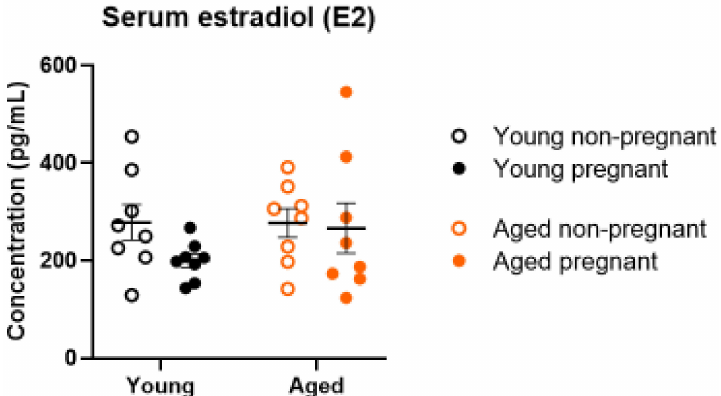
Figure 6. Serum estradiol (E2) concentrations of young (black) and aged (orange) nonpregnant (open circles) and pregnant (GD 20; closed circles) rats. Data presented as mean ± SEM; n = 8/group. Outcomes were compared using a two-way ANOVA (age vs. pregnancy status) followed by Sidak’s post hoc